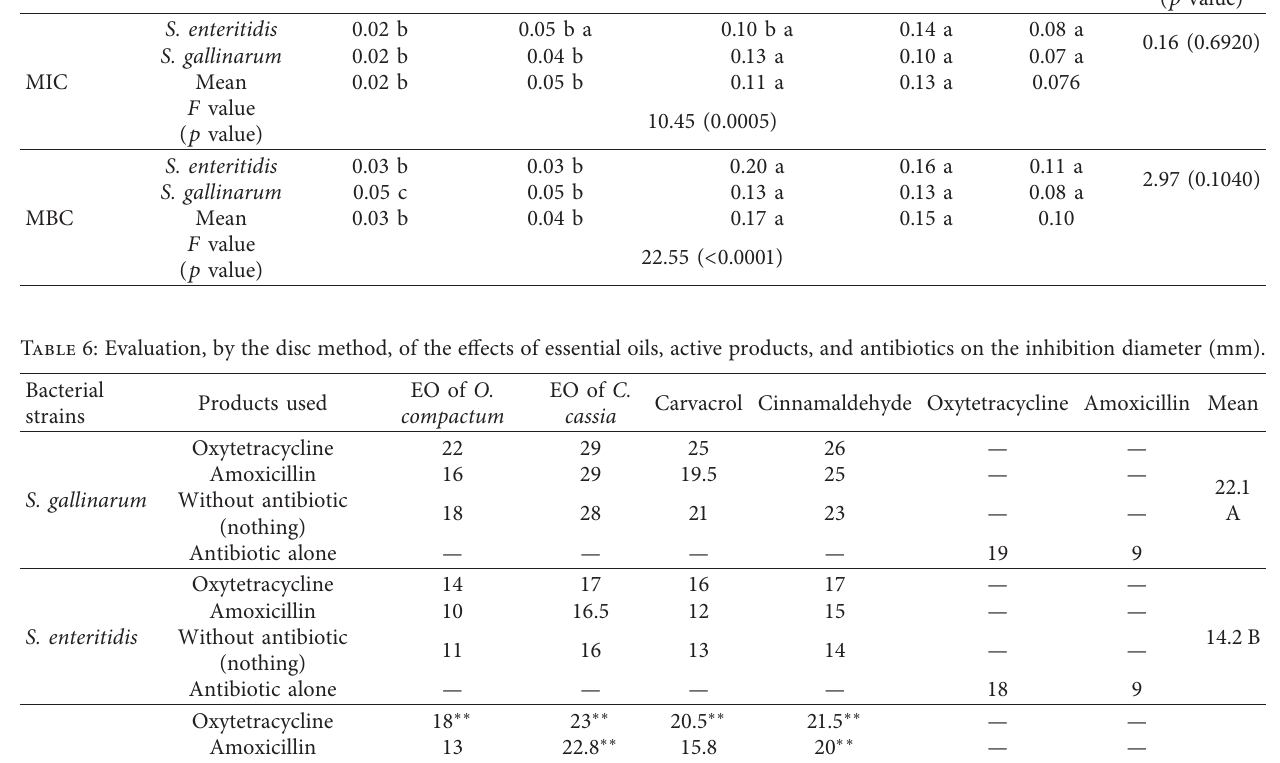
Antibiotic alone